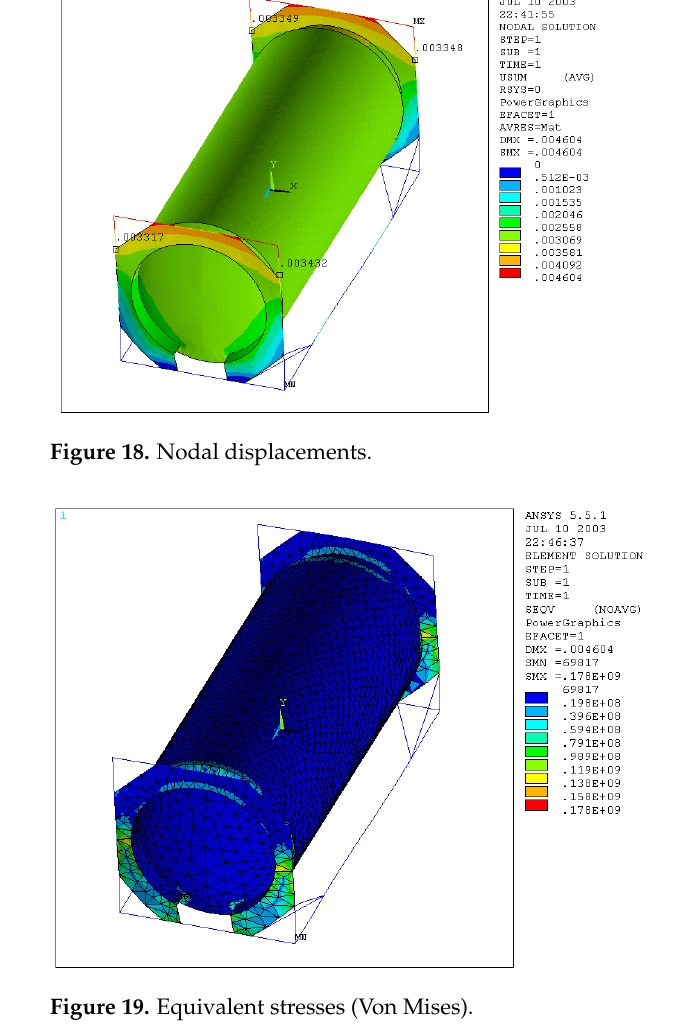
Figure 19. Equivalent stresses (Von Mises).